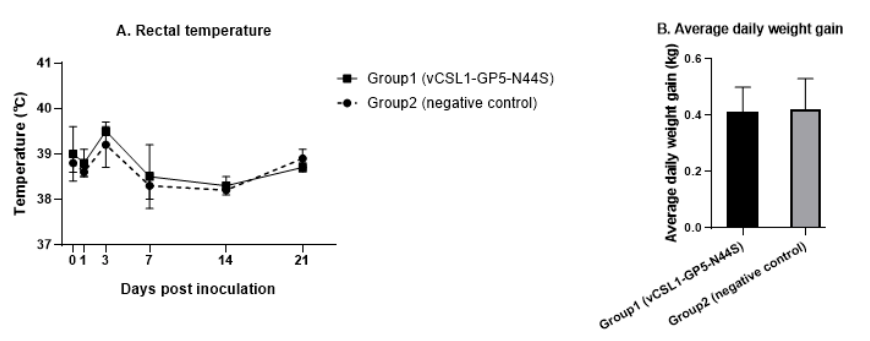
Figure 2. Results of the safety evaluation of vCSL1-GP5-N44S. Four-week-old pigs were assigned to two groups, and each group was intramuscularly injected with 1 mL of vCSL1-GP5-N44S at the dose of 10 5.5 TCID 50 /mL (group 1) and 1 mL of PBS (group 2). ( A ) Rectal temperature was measured 0–21 d post-inoculation. ( B ) Average daily weight gain was calculated by measuring body weight at 0 and 42 d